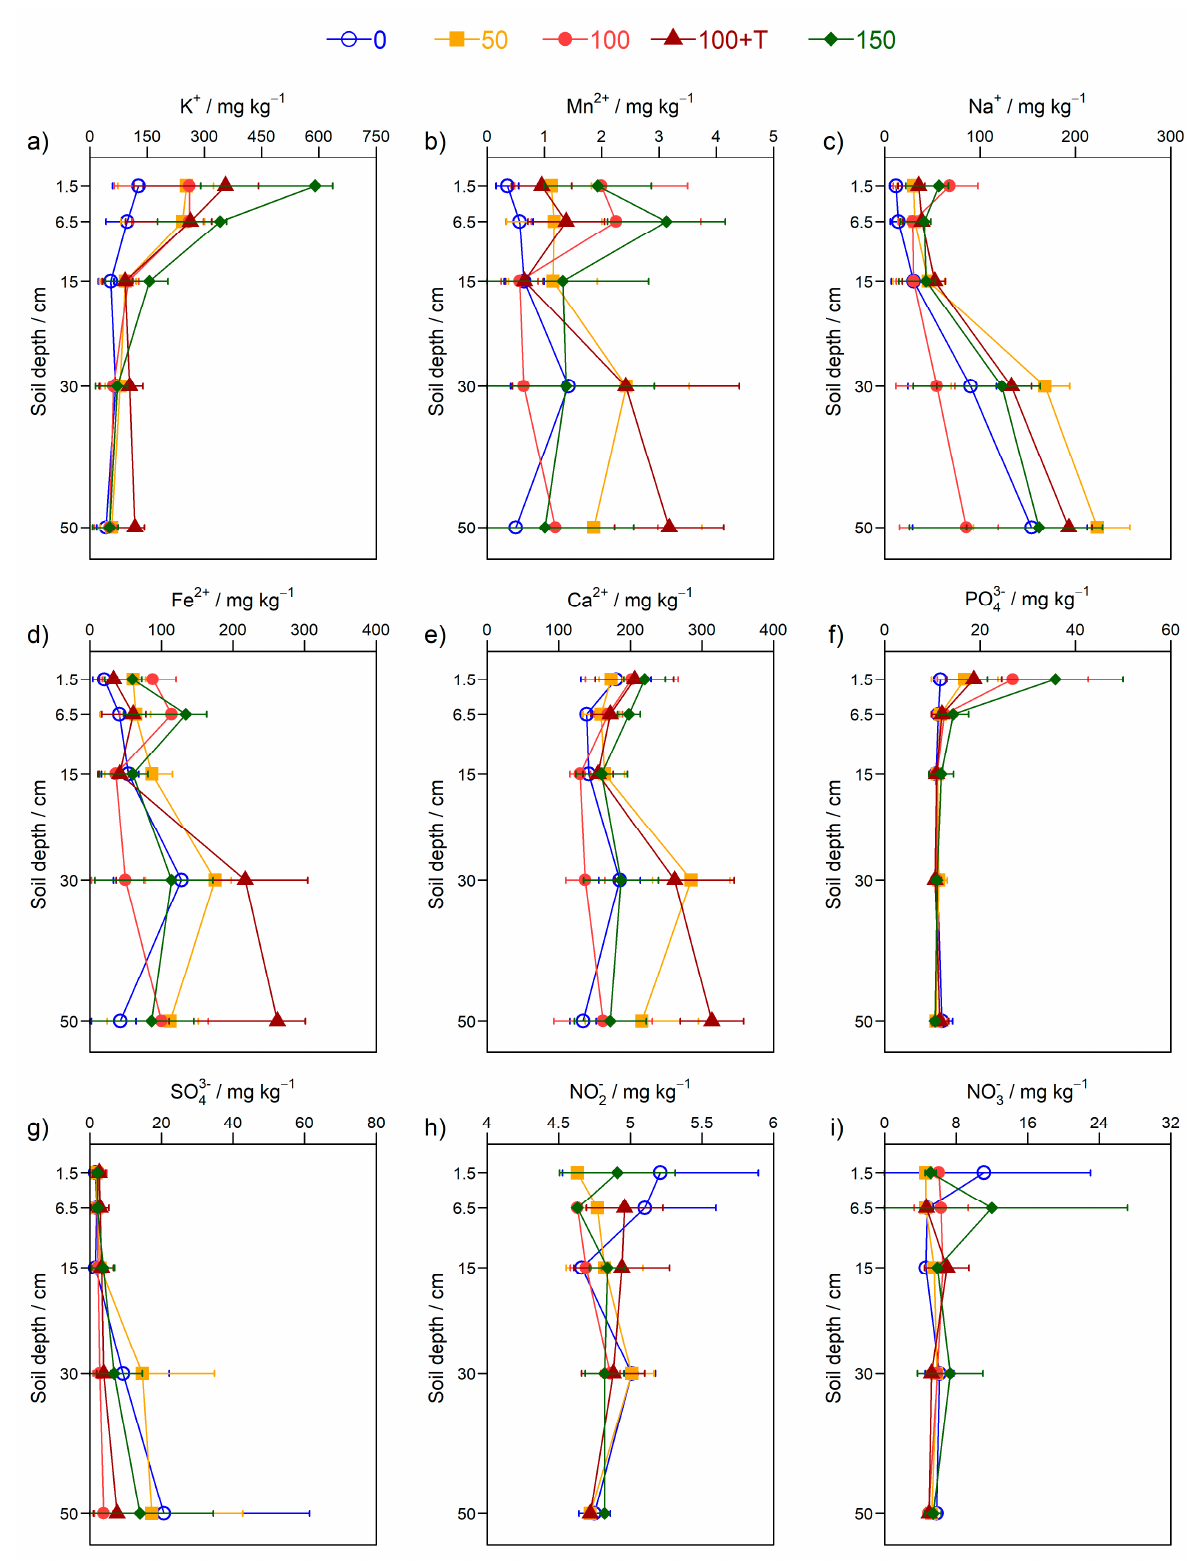
Figure 4. Depth soil profiles of K + ( a ), Mn 2+ ( b ), Na + ( c ), Fe 2+ ( d ), Ca 2+ ( e ), PO 4 3 − ( f ), SO 4 3 − ( g ), NO 2 − ( h ), and NO 3 − ( i ) of the detailed survey before the third OMW application. OMW application rates are 0 (control), 50, 100, and 150 m 3 ha − 1 y − 1 and 100 m 3 ha − 1 y − 1 followed by shallow tillage (100 + T).